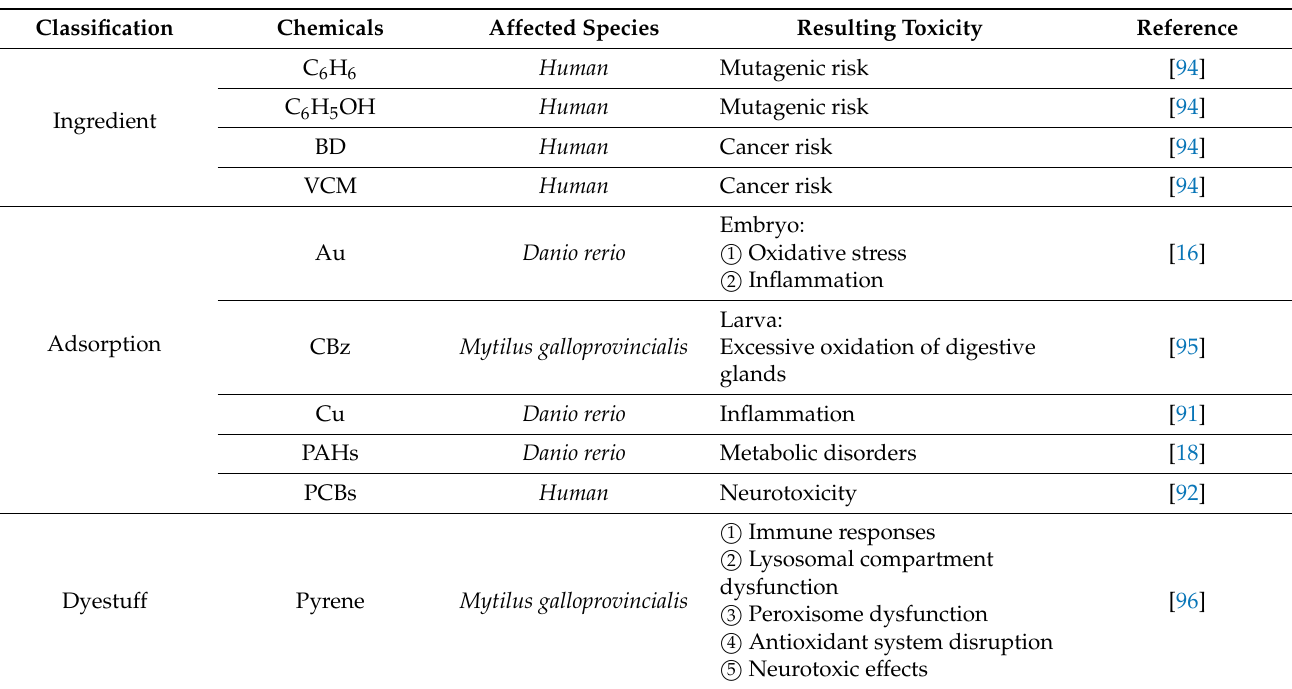
Table 2. Toxic effects of chemicals in microplastics or nanoplastics on